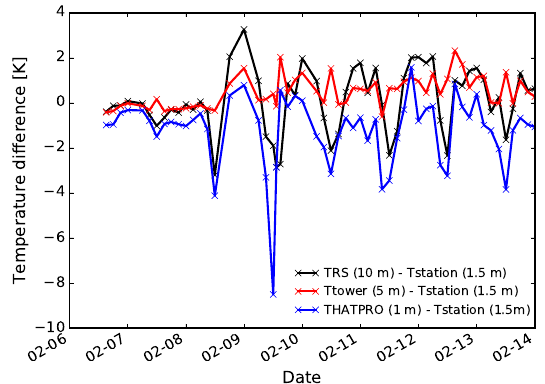
Figure 10. Time series of temperature differences between the first HATPRO level and a surface weather station (blue line), between tower measurements at 5m and the surface station (red line). Ra- diosonde temperature difference (black line) between the surface weather station and the first level